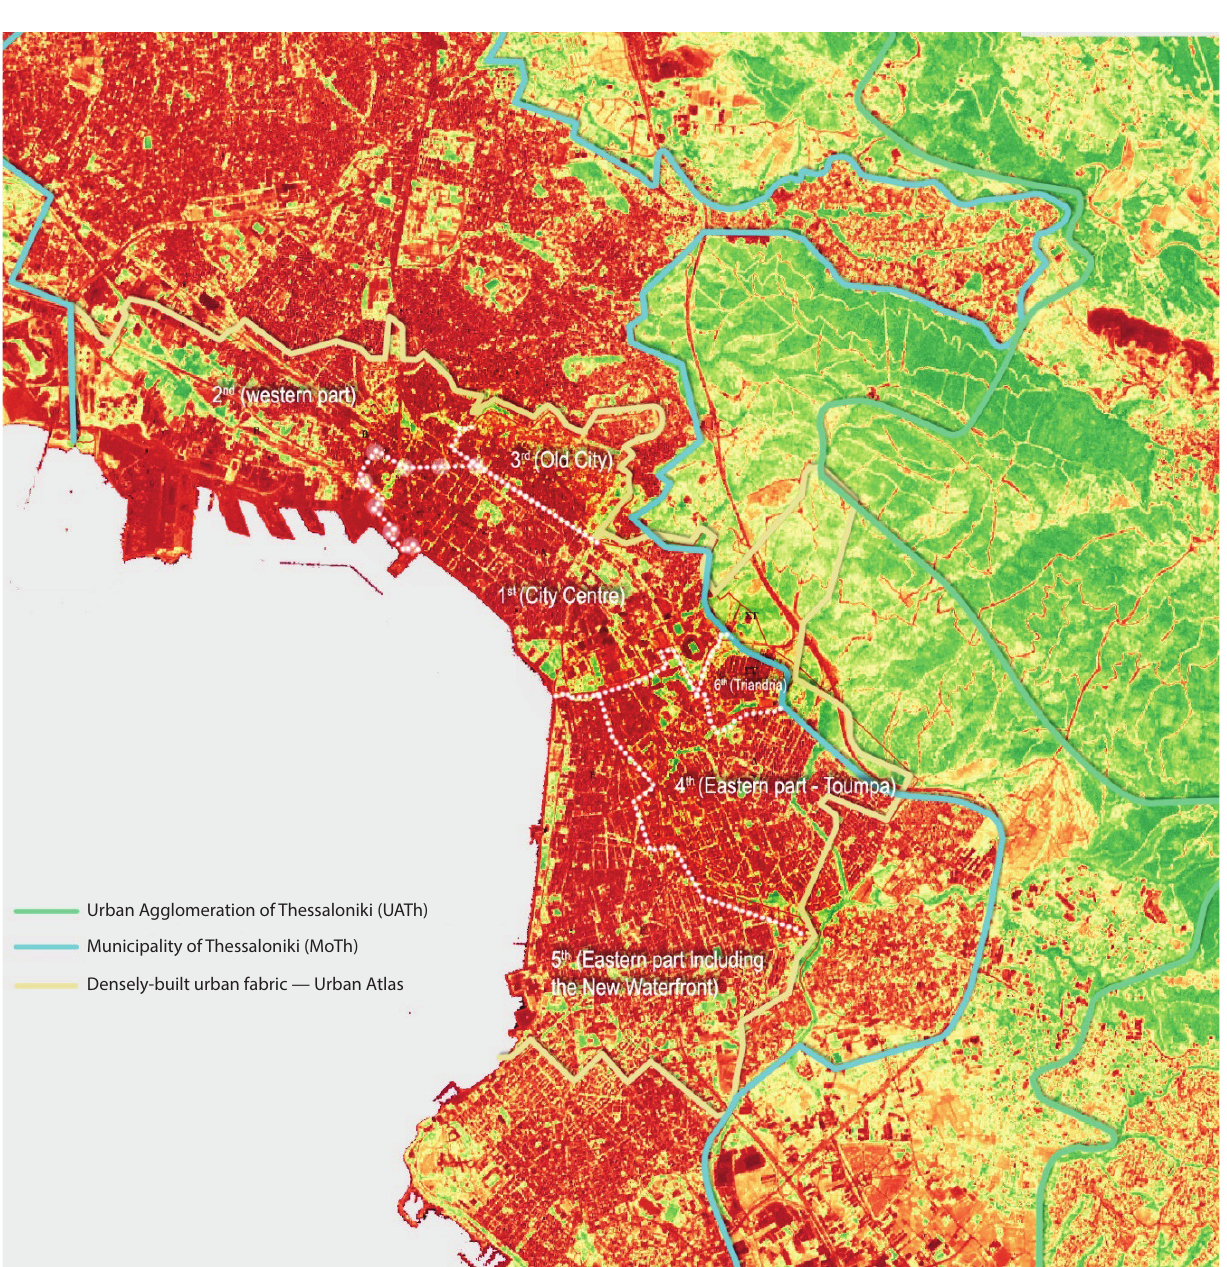
Figure 2. Thessaloniki’s vegetation index based on Sentinel‐2 data. Source: Edited by the author based on MoTh (2022).